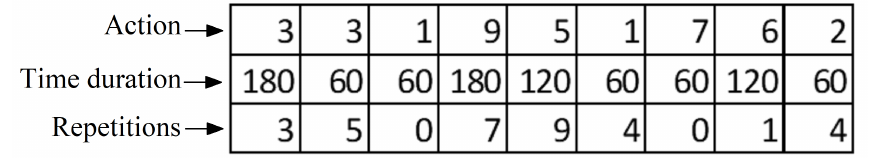
Figure 12. Example of an individual represented by three chromosomes.